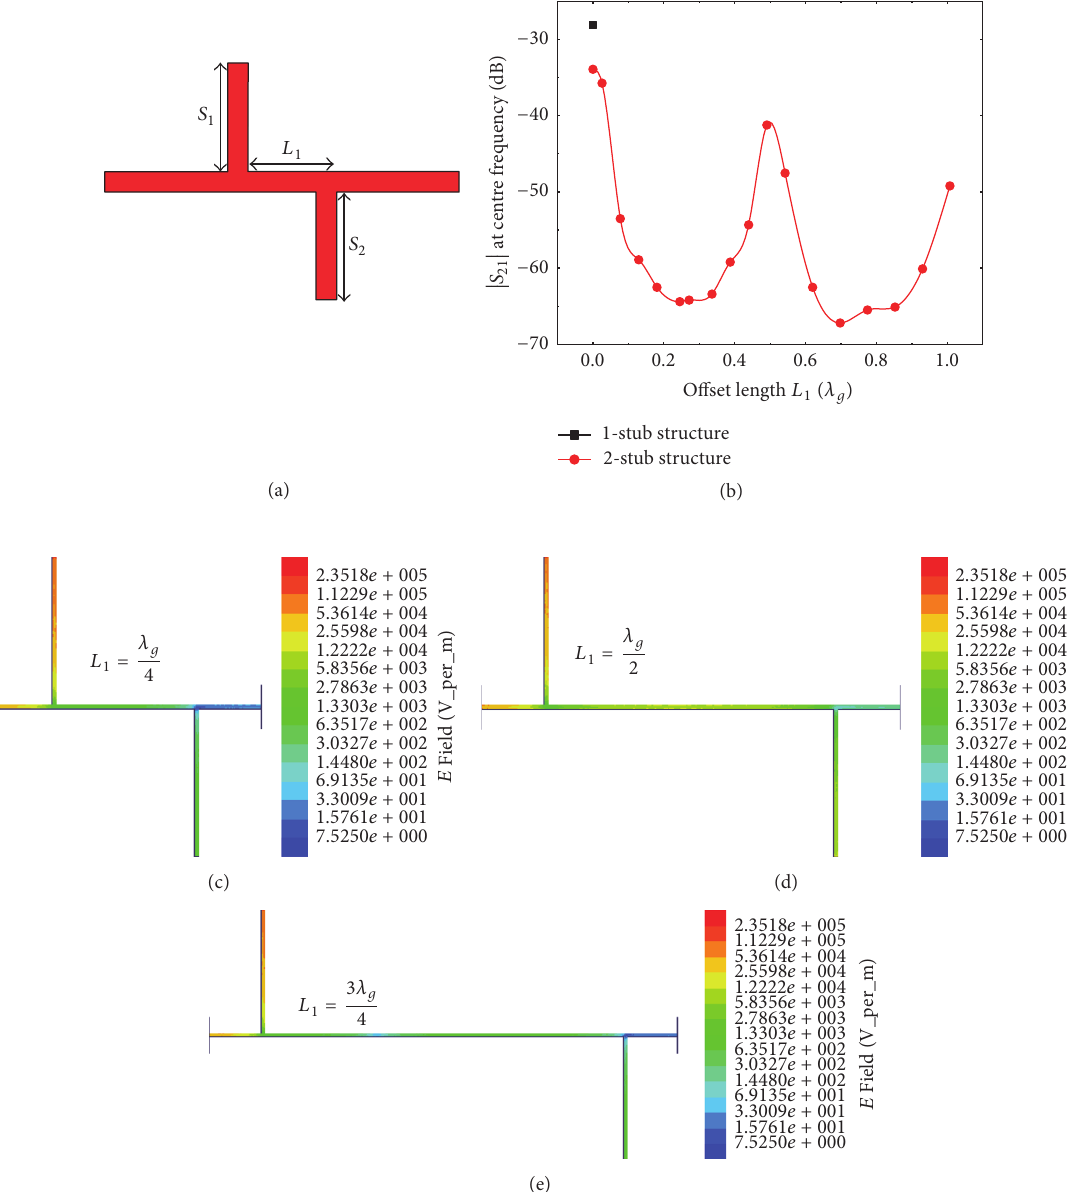
Figure 4: (a) Double-stub structure and (b) its transmission ( |𝑆 21 | ) for 𝑆 1 = 𝑆 2 at the centre frequency with respect to offset length 𝐿 1 , and the electric field distribution when the offset lengths 𝐿 1 are (c) (1/4)𝜆 𝑔 , (d) (1/2)𝜆 𝑔 , and (e) (3/4)𝜆 𝑔 .